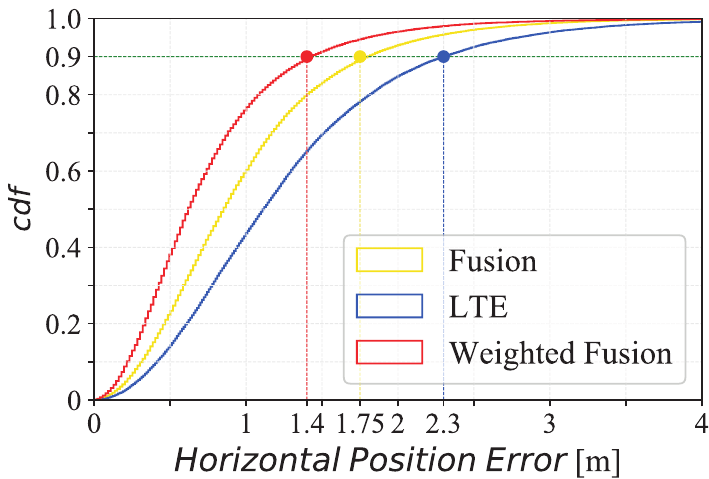
Figure 9. Horizontal Position Error of LTE (blue), fusion (yellow) and weighted fusion